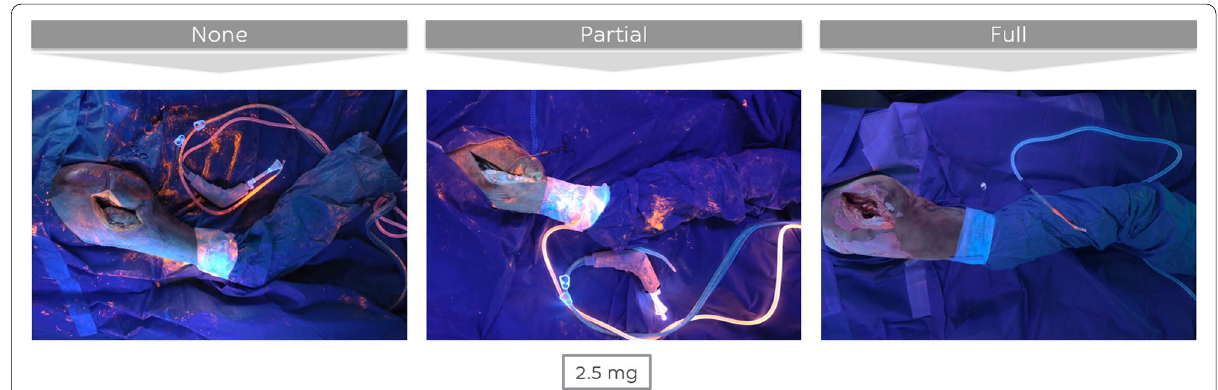
2,5 mg of GloGerm ×